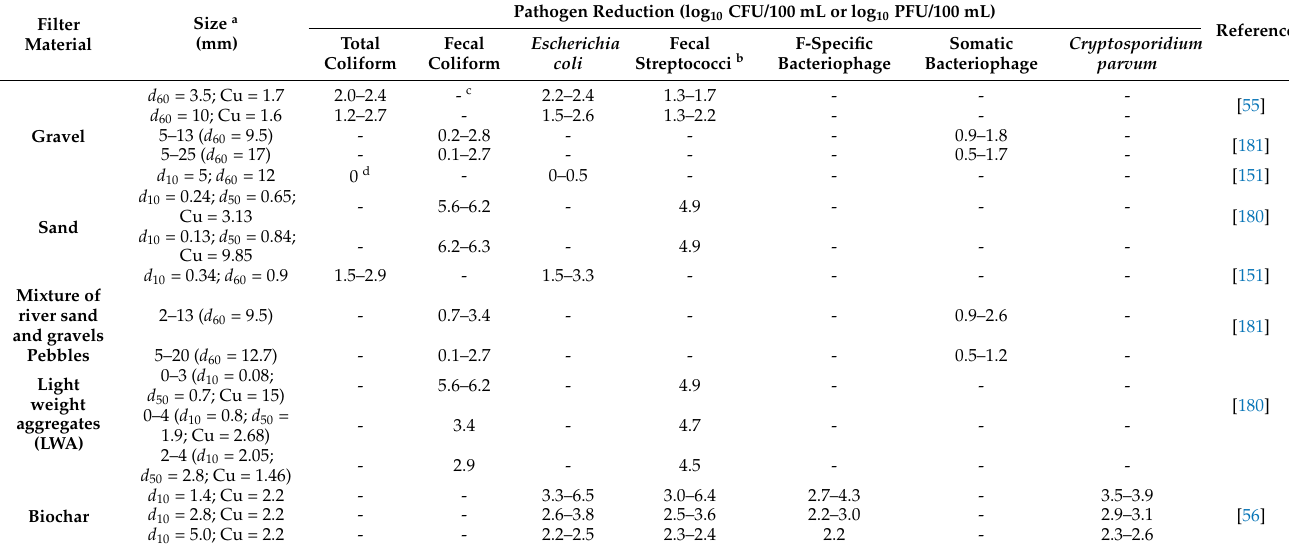
Table 3. The removal performance of pathogens in OWTSs with various grain sizes of the filter media. Filter Material